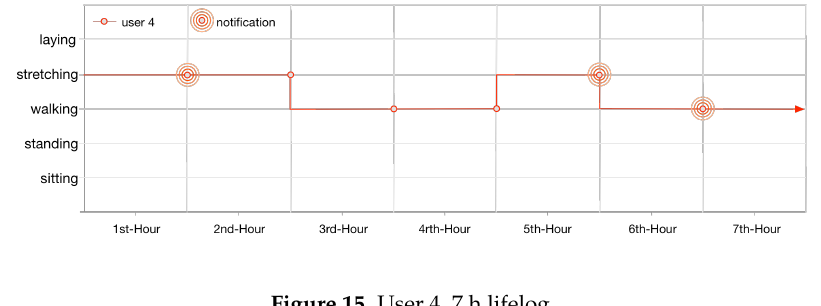
Figure 15. User 4, 7 h lifelog.